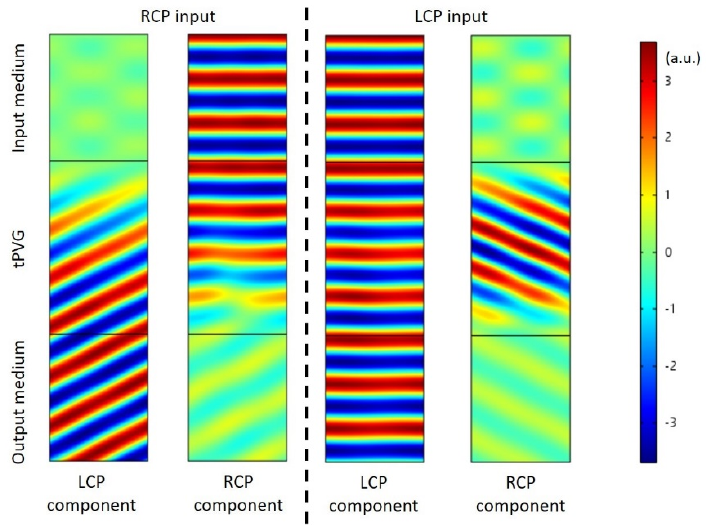
Figure 11. Electric field distribution in a polarization converting transmissive PVG. Scale bar indicates the electric field distribution. Tilt originates from the diffraction of the transmissive PVG.